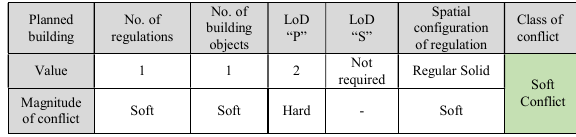
Table 5. Classification of the magnitude of building height regulation conflict